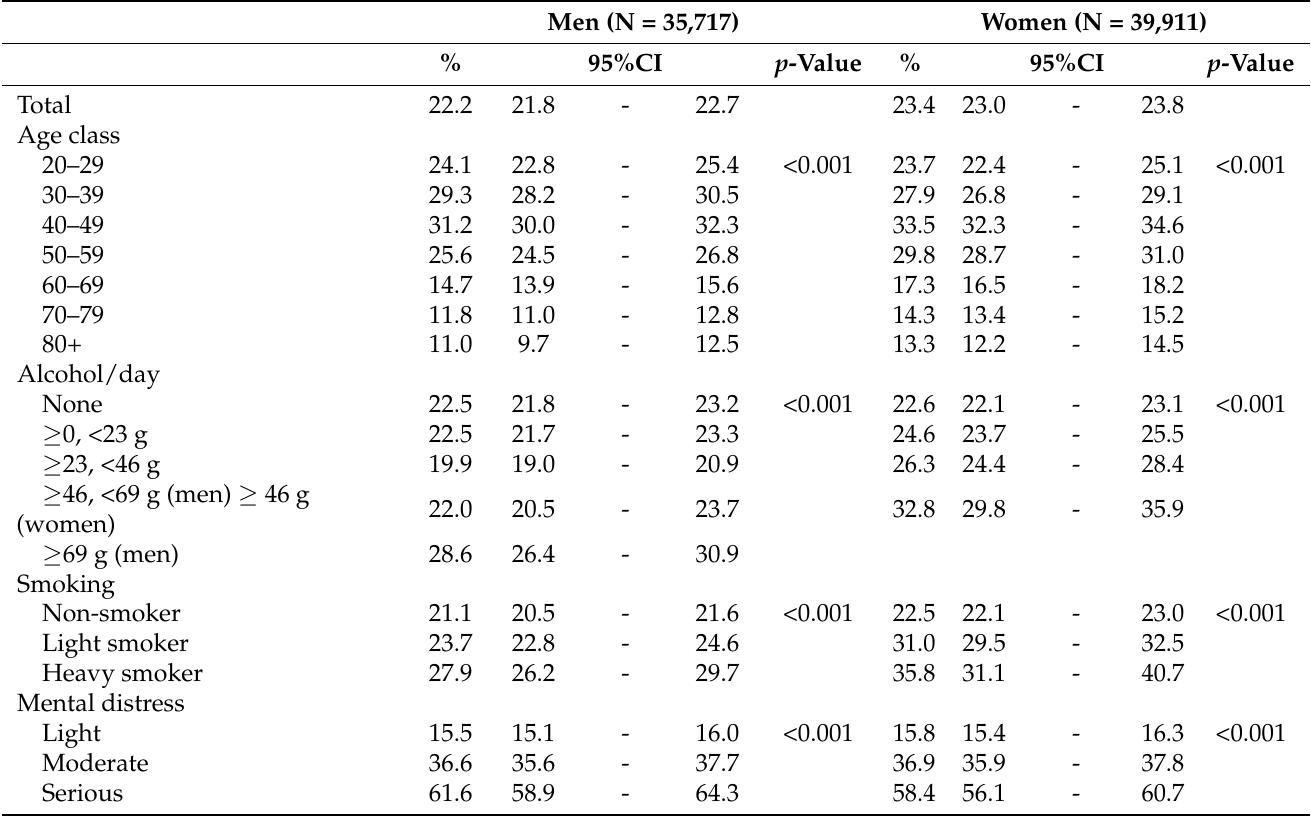
Table 2. Prevalence of Nonrestorative Sleep (NRS) by Demographic